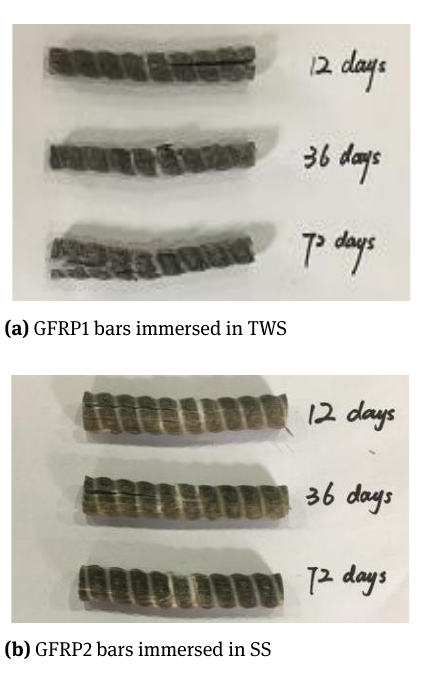
Figure 10: Typical failure mode of conditioned GFRP bars in the short-beam shear